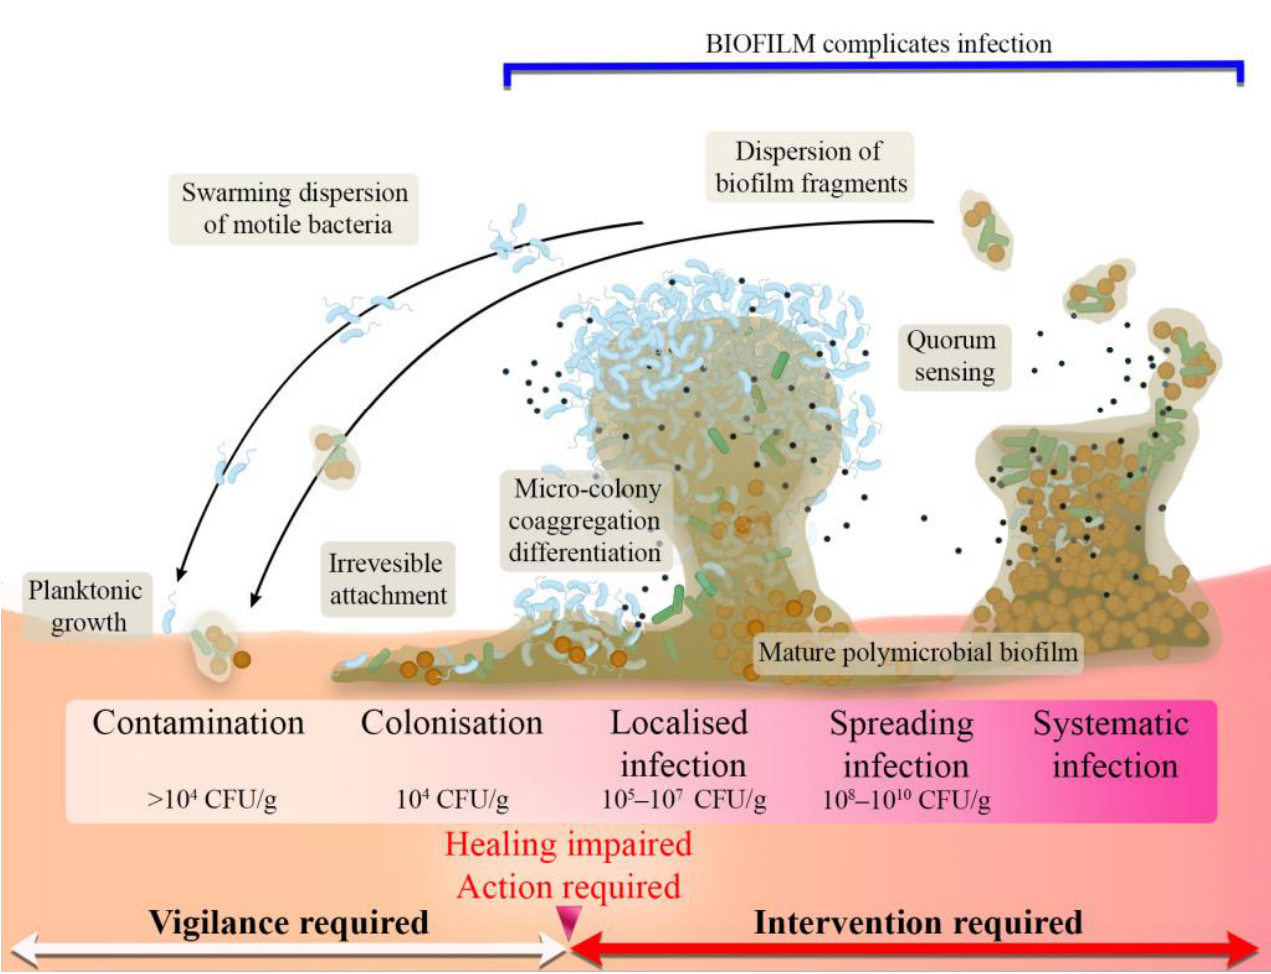
Figure 1. Scheme presenting the wound infection continuum (reproduced from [38] with permission from the Wounds Group, OmniaMed Communications; own modifications were introduced based on information found in [38 – 40]).